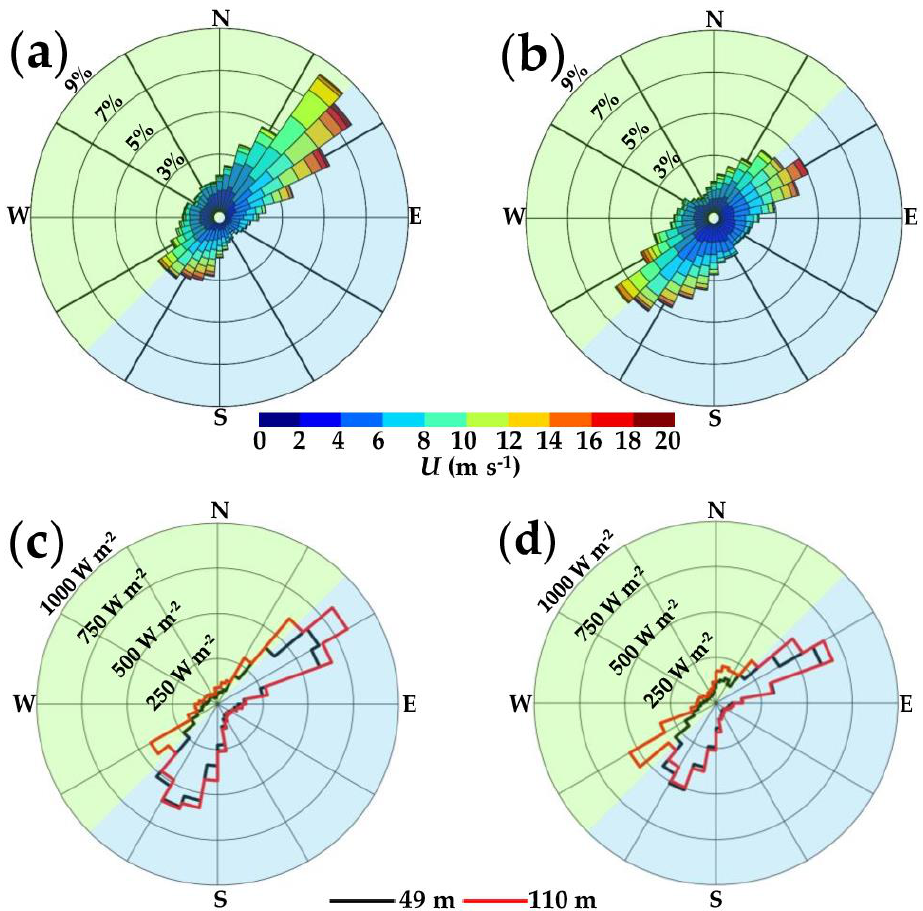
Figure 4. Panels ( a , b ) refer to directional histograms for wind speed measured by the LIDAR at 110 m high for the years of 2017 and 2018, respectively. The direction follows the meteorological convention (direction from which the wind blows). The colored bars illustrate the wind speed. Panels ( c , d ) are the directional power densities calculated from U for the years 2017 and 2018, respectively. The black lines and red lines represent D p at 49 m and 110 m heights, respectively. The concentric circles represent the frequency of U in panels ( a , b ) and magnitude of D p in panels ( c , d ). A 10 ◦ directional sector resolution is employed. The colored backgrounds represent the continental (light green) and oceanic (light blue) regions.